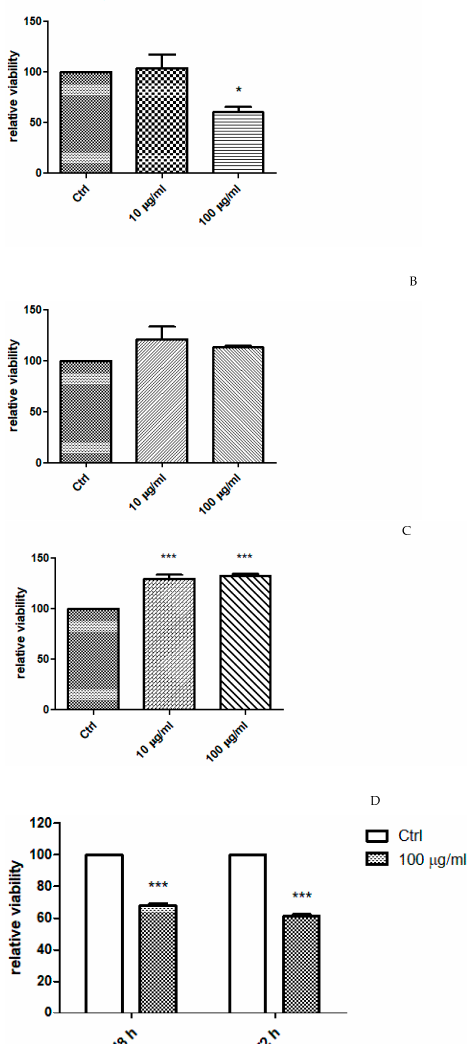
Figure 3. ( A ) Inhibitory effect of the ethyl acetate extract 10–100 µg/mL from the aerial parts of Pelargonium quercetorum on human colon cancer HCT116 cell viability. * p < 0.05 vs. Ctrl group. ( B ) Null effect of the methanol extract 10–100 µg/mL from the aerial parts of Pelargonium quercetorum on human colon cancer HCT116 cell viability. ( C ) Stimulatory effect of the water extract 10–100 µg/mL from the aerial parts of Pelargonium quercetorum on human colon cancer HCT116 cell viability. *** p < 0.001 vs. Ctrl group. ( D ) Inhibitory effect of the ethyl acetate extract 100 µg/mL from the aerial parts of Pelargonium quercetorum on human colon cancer HCT116 cell viability, after 48 and 72 h of exposure to the extract (*** p < 0.001).